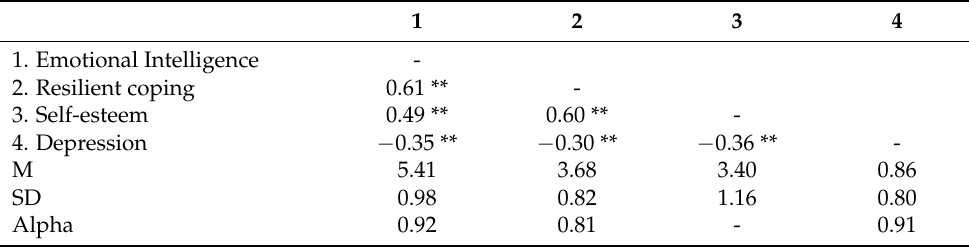
Table 1. Means, standard deviations, reliabilities and correlations of the variables of interest. 1 2 3 4